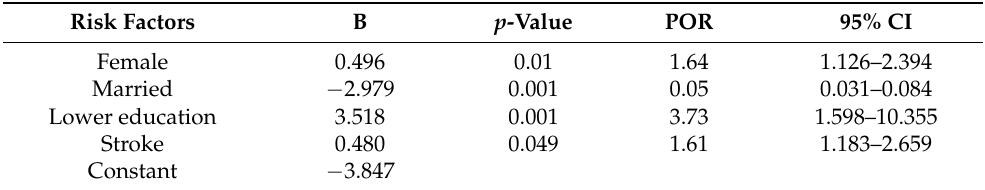
Table 3. Binary logistics regression of risk factors for